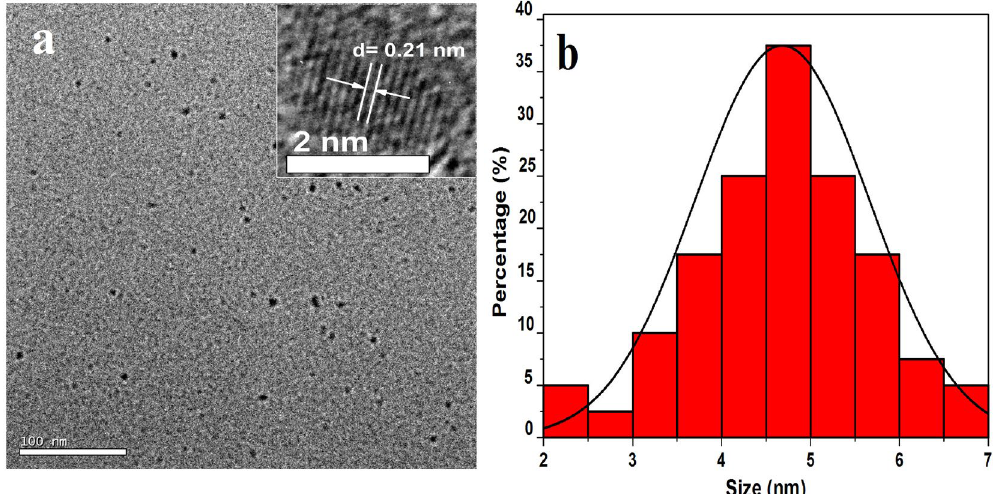
Figure 2. ( a ) The TEM and (inset) HRTEM image ( b ) and size distribution of the green-emitting